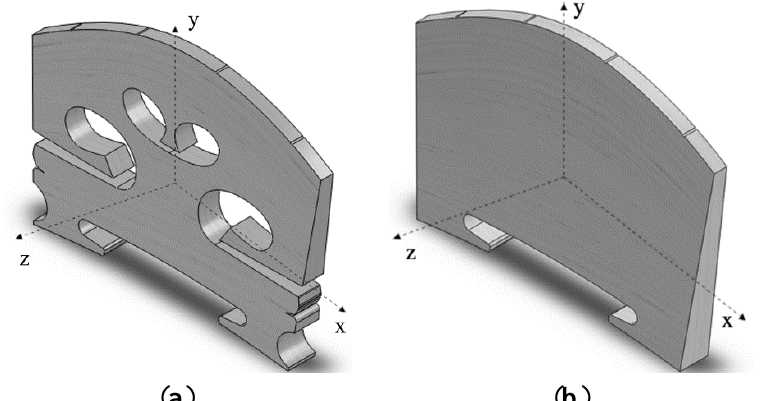
Figure 1. Geometrical models. ( a ) A real bridge; ( b ) A plate solid